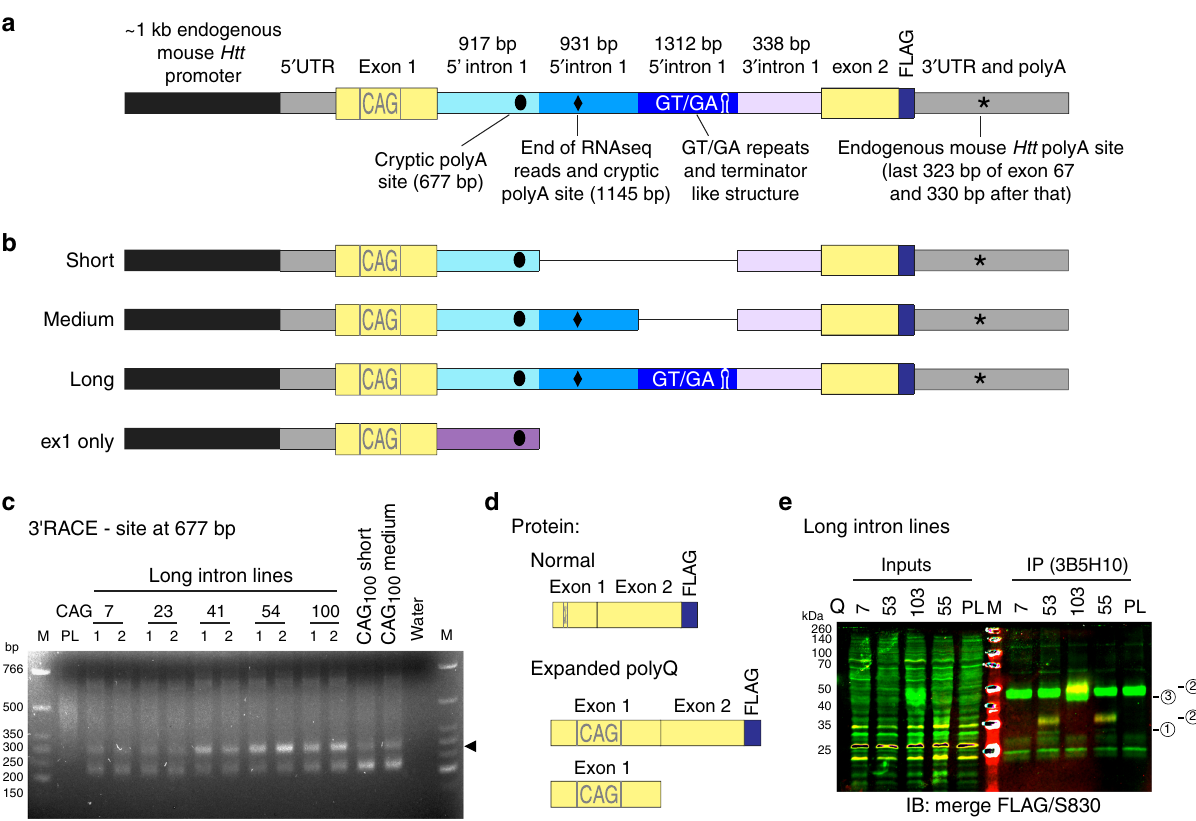
Fig. 1 Development of a cell based system that recapitulates incomplete splicing of Htt . a Schematic showing the elements of the Htt minigenes. b Three minigene constructs differed only in the length of 5 ′ intron sequences (short: 917 bp; medium: 1848 bp; long: 3160 bp). One construct contained only the coding sequence for exon 1 HTT and the fi rst 916 bp of intron 1 (ex1 only). c 3 ′ RACE analysis showed that the cryptic polyA site at 677 bp into intron 1 (arrowhead) was only used in the long minigene lines with a threshold of about 40 CAGs. d Proteins that will be expressed from these constructs: Splicing will generate an exon 1-exon 2-FLAG fusion protein (control and expanded CAG). In the case of an expanded CAG, an exon 1 HTT protein will also be generated due to incomplete splicing of exon 1 to exon 2. e Overlay image of spliced (FLAG) and exon 1 HTT (S830) containing fragments. HTT fragments were immunoprecipitated (IP) with 3B5H10 coupled magnetic beads and immunoprobed (IB) with antibodies as indicated (please see Supplementary Fig. 2 for complete protein analysis). FLAG-tag detects the properly spliced exon 1 – exon 2 fragment (2) (see also Fig. 1d). The S830 antibody recognized Q50 and Q100 containing spliced (2), as well as incompletely spliced fragments (1: Q50, 3: Q100). Q7 containing fragments were not detected because they